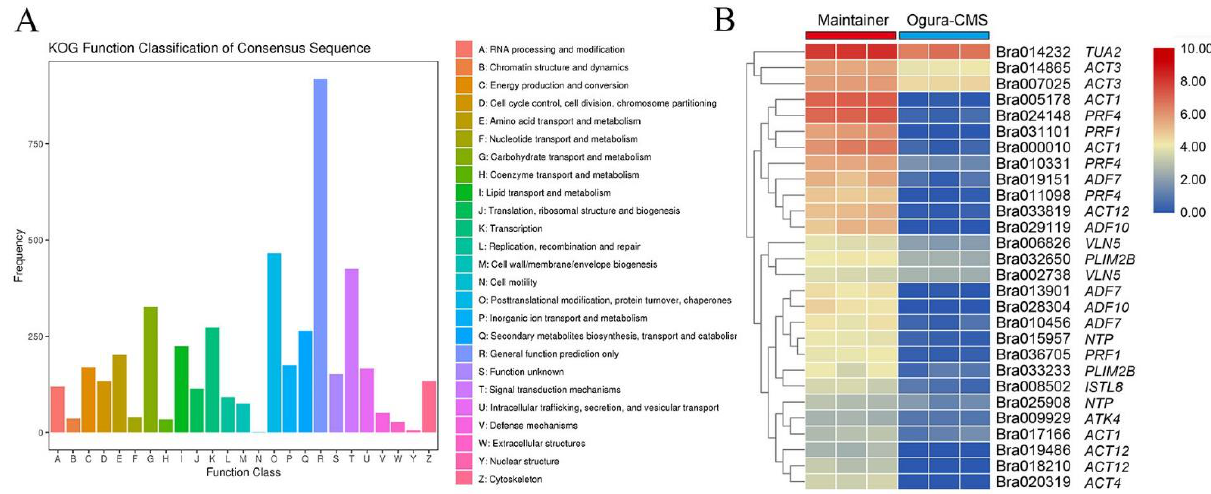
Figure 4. The differentially expressed genes by KOG enrichment in the Ogura CMS (Tyms) and its maintainer (231–330) lines; ( A ) KOG clusters involving DEGs; ( B ) heatmap of DEGs that are related to the cytoskeleton (Z) according to KOG enrichment analysis.